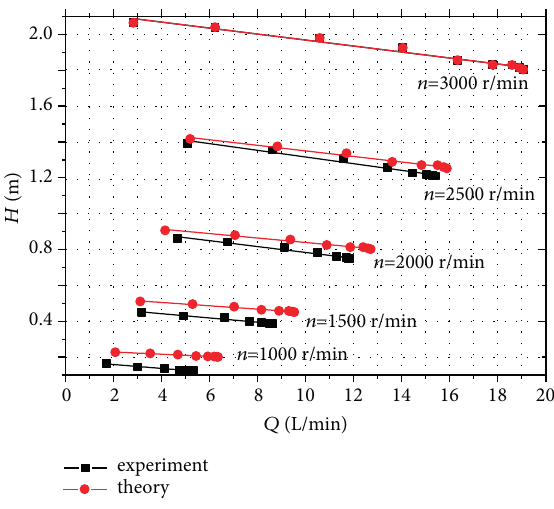
Figure 9: Pump similarity theory test.